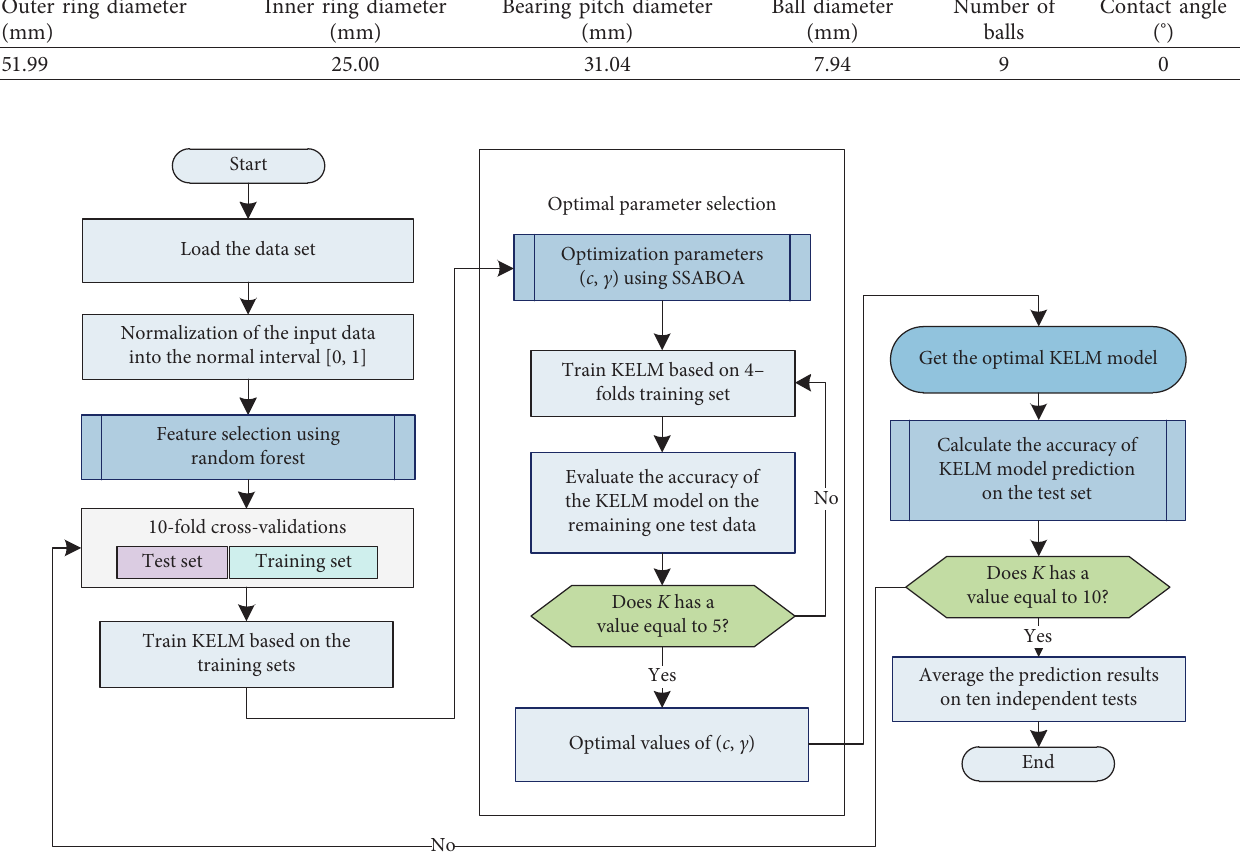
Figure 1: Flowchart of SBOA-KELM.